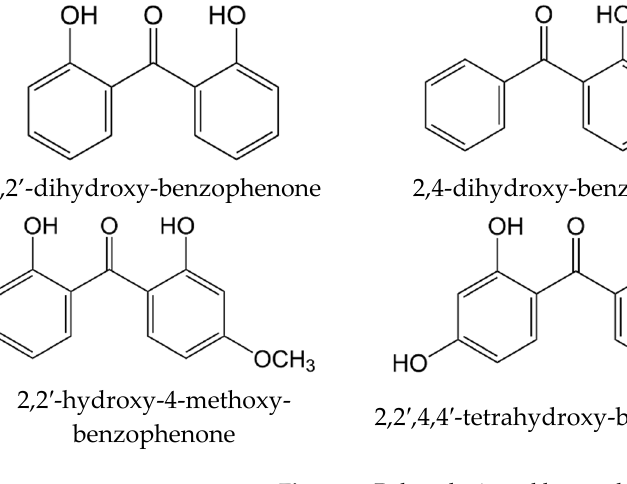
Figure 2. Poly ‐ substituted benzophenones studied in this work.